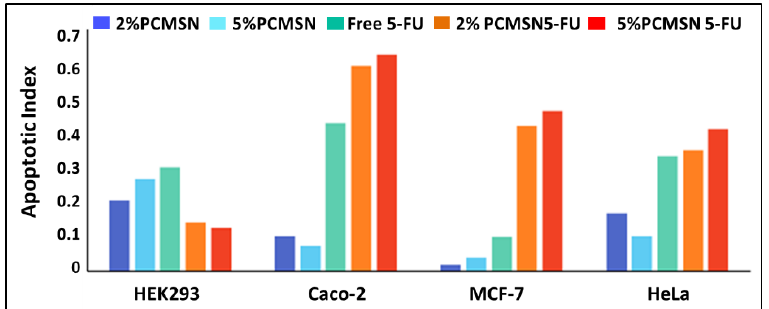
treated with 5% PEG-CHIT-MSN (20 × magnification).